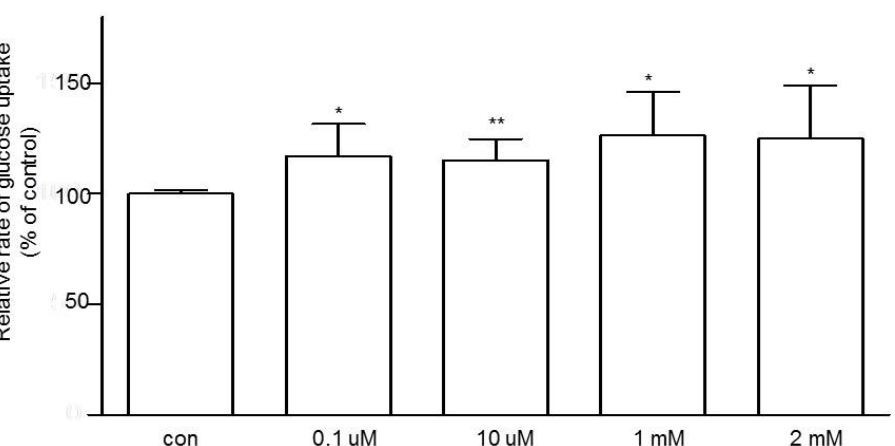
Figure 3. The dose-dependent effect of niacin on jejunal glucose uptake using 10-week-old m+/db mice. Data are expressed as relative percentage of glucose uptake relative to the control (con). n = 6 for each concentration of niacin. Data are given as means ± standard error of the mean (SEM), * p < 0.05 vs. control; ** p < 0.01 vs. control.